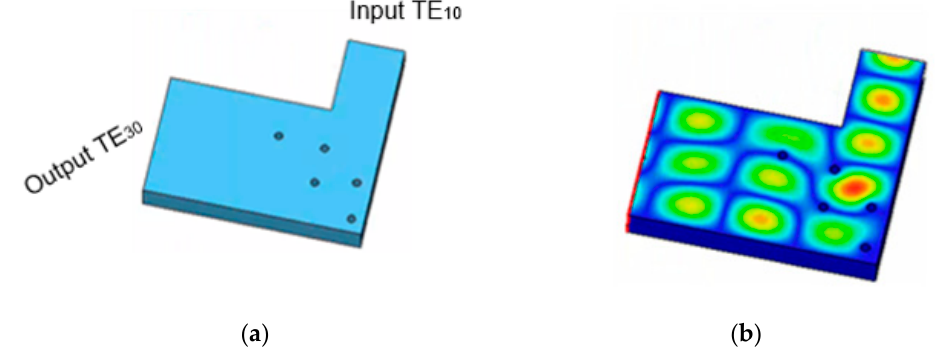
Figure 5. ( a ) Normalized phase velocity versus frequency. ( b ) Normalized group velocity versus frequency.